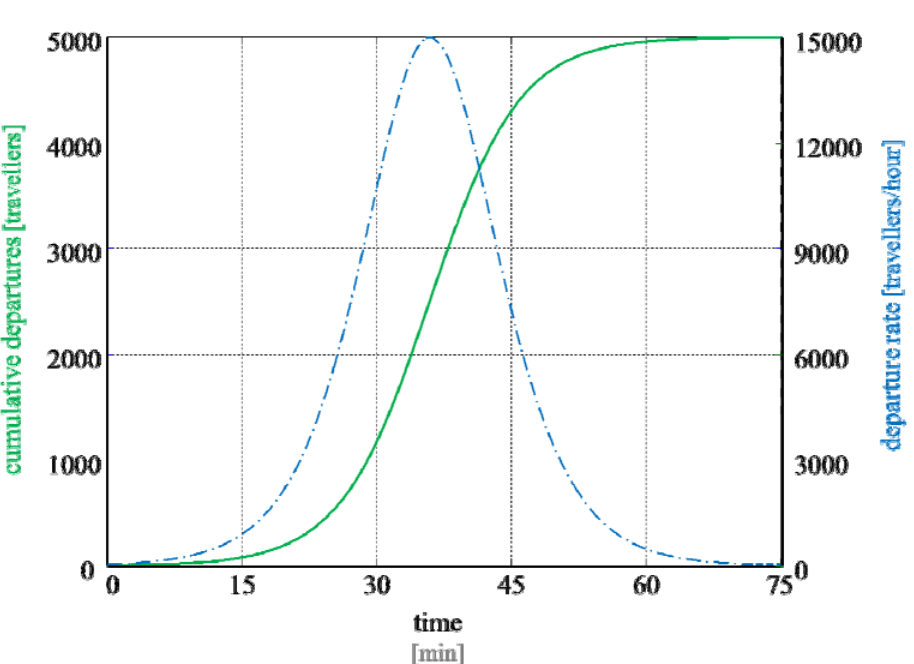
Figure 4. Preferred departure profile for a single origin ( α = 12 and h = 0.6): solid green graph shows cumulative departures [travellers], and dash-dotted blue graph shows departure rate